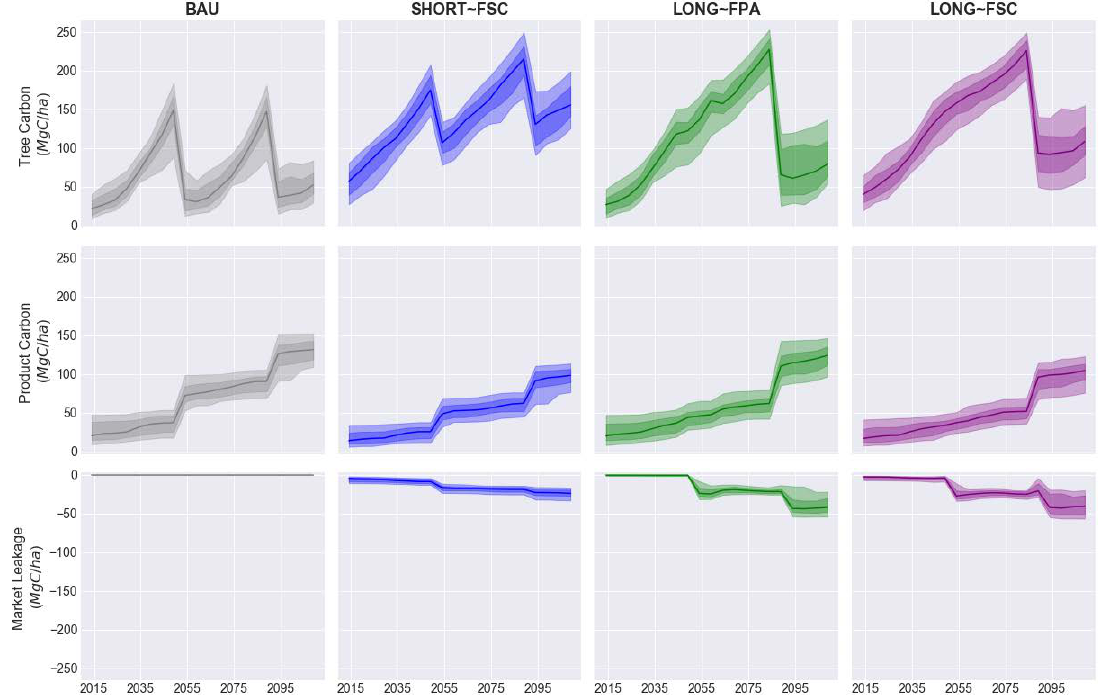
Figure 5. Carbon stored in three primary categories of pools/emissions under four alternative management scenarios. The dark line in each graph represents the median value over time across the 64 parcels. The shaded areas correspond to the 25th–75th percentile range (darker), and the 10th–90th percentile range (lighter).